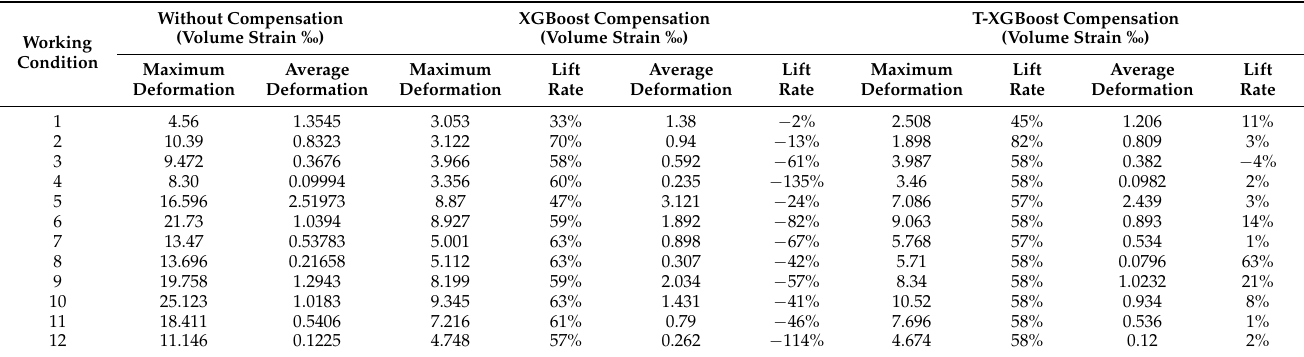
Table 5. Compensation results under different working